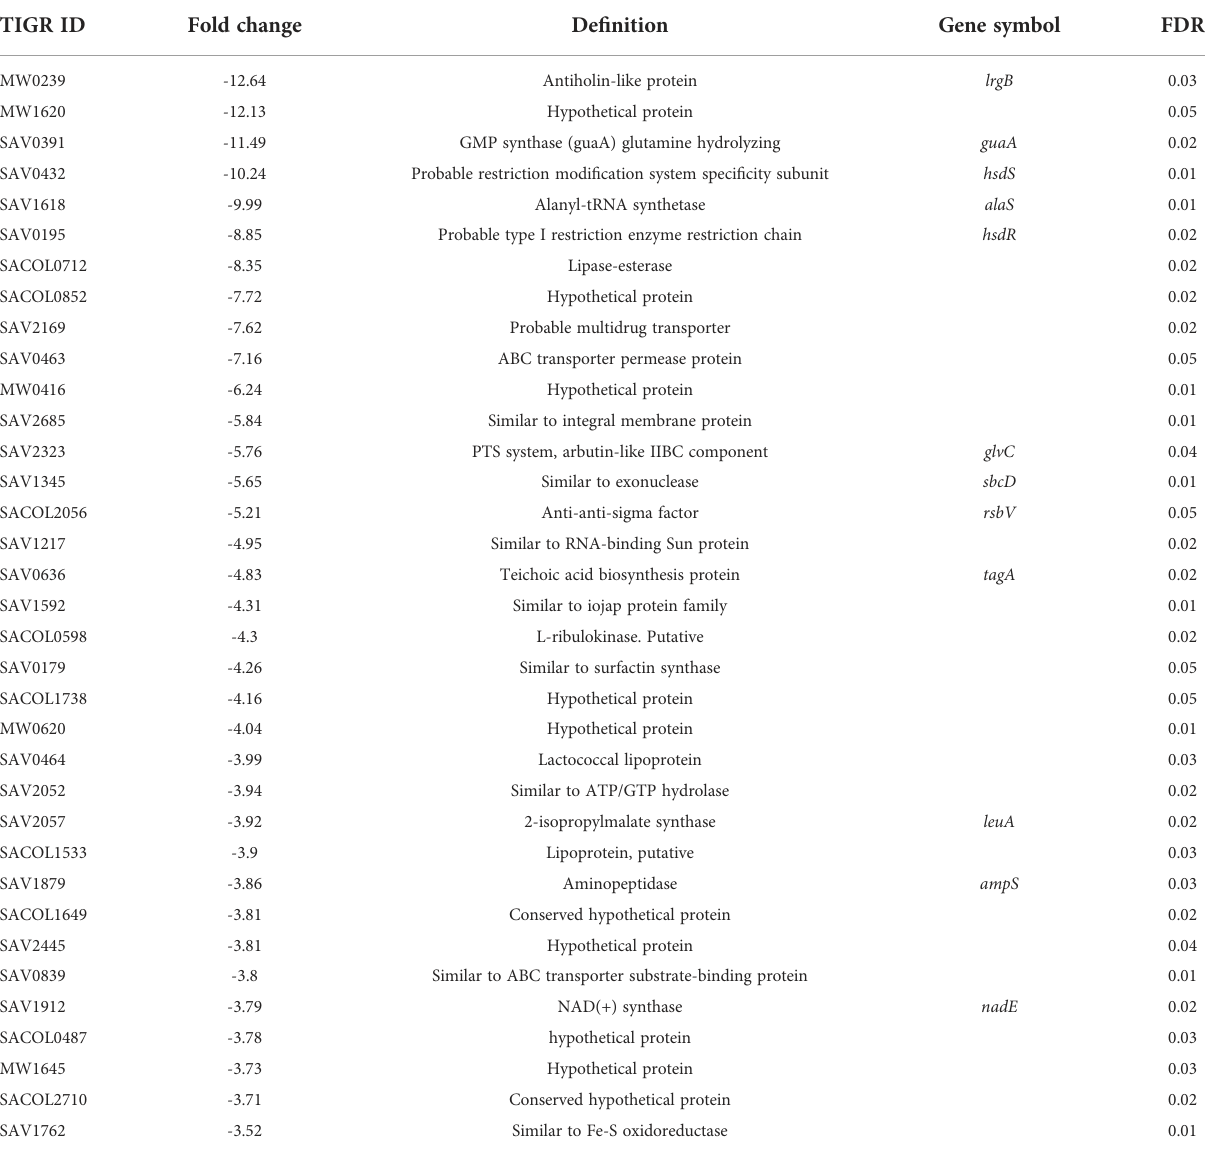
TABLE 2 Down regulated genes in gurmarin treated S. aureus bio fi